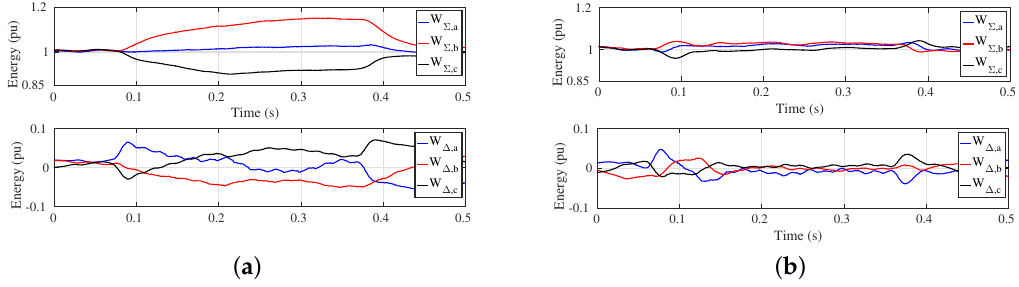
Figure 16. ( a ) W Σ and W ∆ for Scenario 2 without energy controllers and ( b ) with energy controllers.